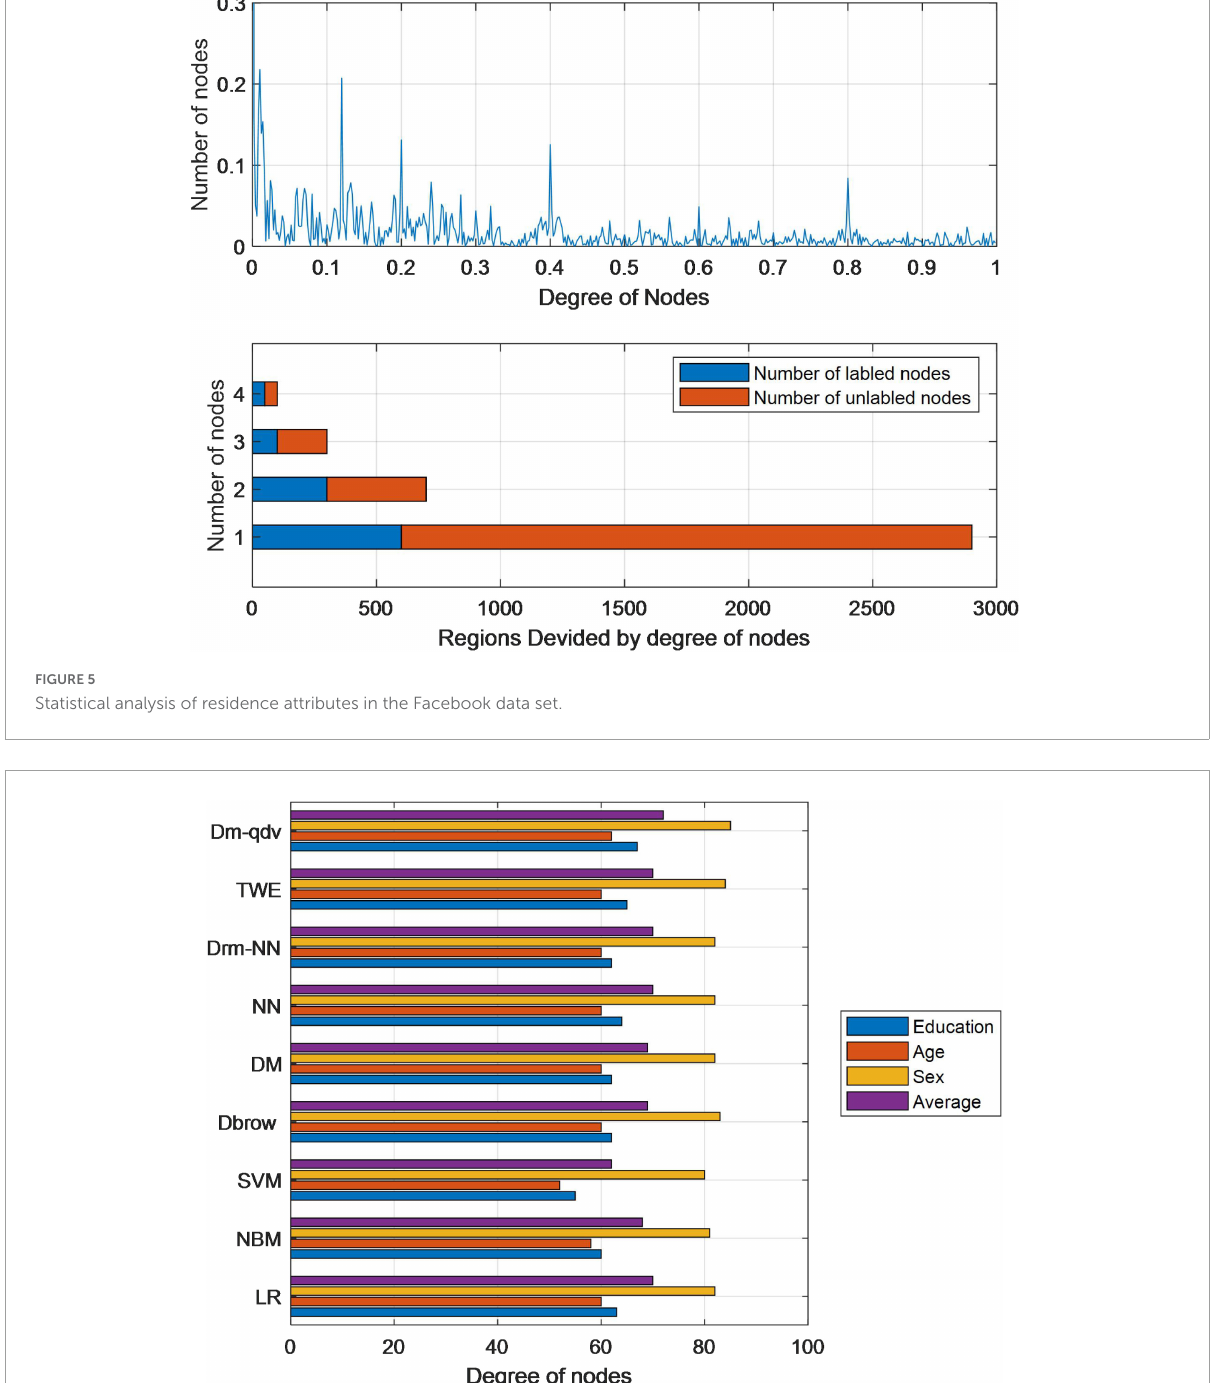
FIGURE6 Bar chart of comparison of various models.